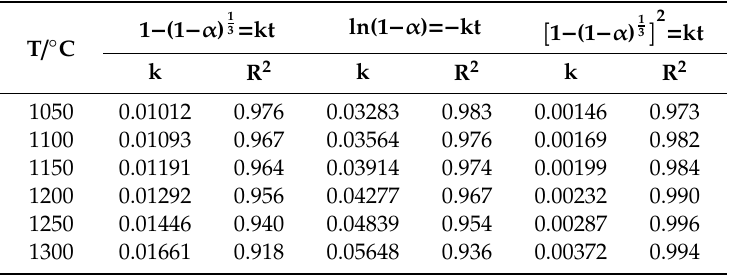
Table 6. The fitting parameters of the Arrhenius Equation of various kinetic models (Equations (2)–(4)). Table 5. The fitting parameters of di ff erent kinetic models under various Parameters